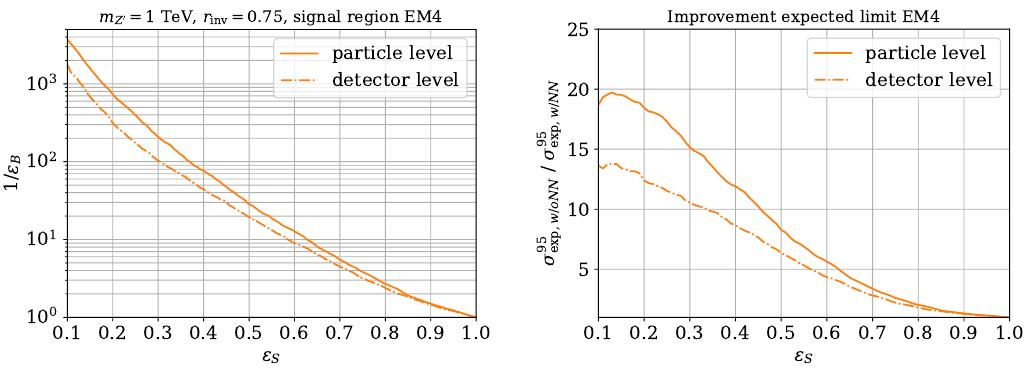
Figure 7: Left: Event-level ROC curves for a mono-jet search including a DGCNN dark shower tagger. Shown are the additional background event rejection and signal event efficiency relative to the search without a tagger. Right: Corresponding im- provement of the expected limit on the dark shower production cross section. The jet constituents used as input for the DGCNN are either at the particle (solid lines) or detector level (dash-dotted